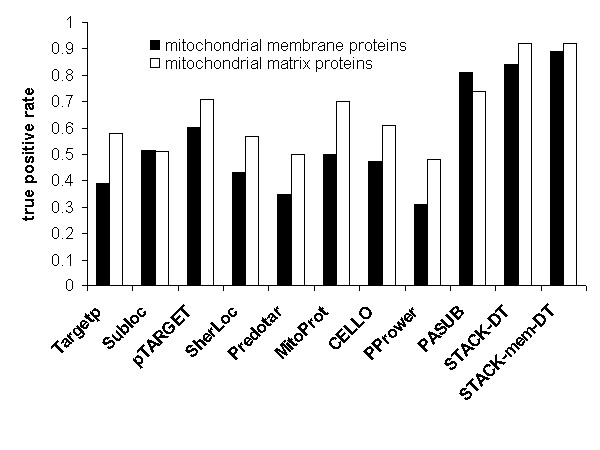
Prediction performance of individual and integrated tools on yeast mitochondrial membrane and matrix proteins. Loc-tools recognize mitochondrial membrane proteins less efficiently than matrix proteins. The effectiveness of PASUB is due to the fact that it exploits annotations and that the portion of annotated mitochondrial membrane proteins is higher compared to matrix proteins.